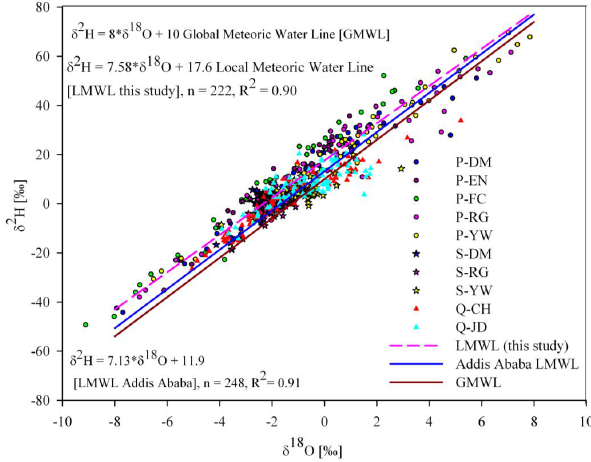
Fig. 3. Relationship between, δ 18 O and δ 2 H for precipitation, stream and spring water Figure 3. Relationship between δ 18 O and δ 2 H for precipitation, in the study area. The abbreviations in the legend are described in Table 2. stream and spring water in the study area. The abbreviations in the legend are described in Table